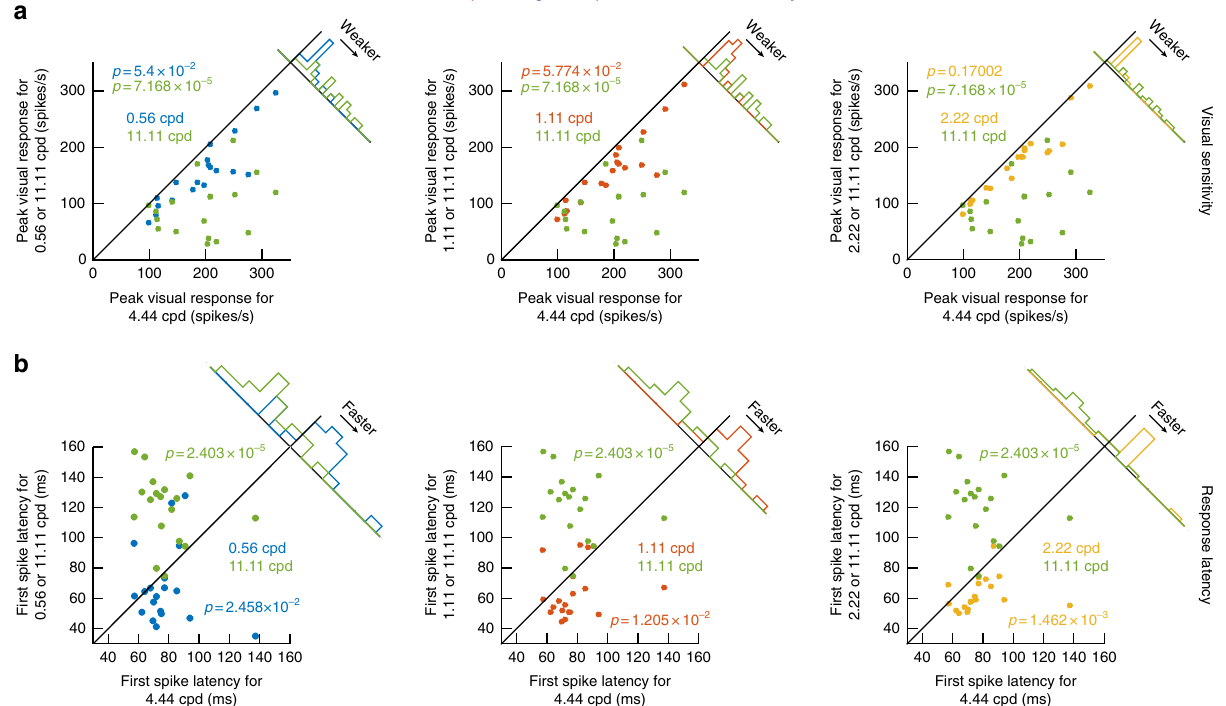
Fig. 2 Rapid primate SC detection of low spatial frequencies independent of neural sensitivity. a For neurons showing the highest visual responses to 4.44 cpd gratings ( N = 19), we plotted in each panel visual response strength for either higher or lower spatial frequencies ( y -axes) against response strength for 4.44 cpd. As expected, response strength was always highest for 4.44 cpd. p -values are indicated in each panel, re fl ecting a comparison between either the higher or lower spatial frequency (color-coded according to the legend) to 4.44 cpd using a Ranksum test. b First-spike latency for 4.44 cpd gratings ( x -axes) and either lower or higher spatial frequencies ( y -axes). Even though 4.44 cpd gratings always evoked the strongest response ( a ), fi rst-spike latency was either longer or shorter than the latency for other gratings ( p -values are indicated in each panel); whether fi rst-spike latency for the preferred spatial frequency (4.44 cpd) was longer or shorter simply depended on the rank-ordering of spike timing observed in Fig. 1. Thus, early SC visual sensation for low spatial frequencies is independent of response